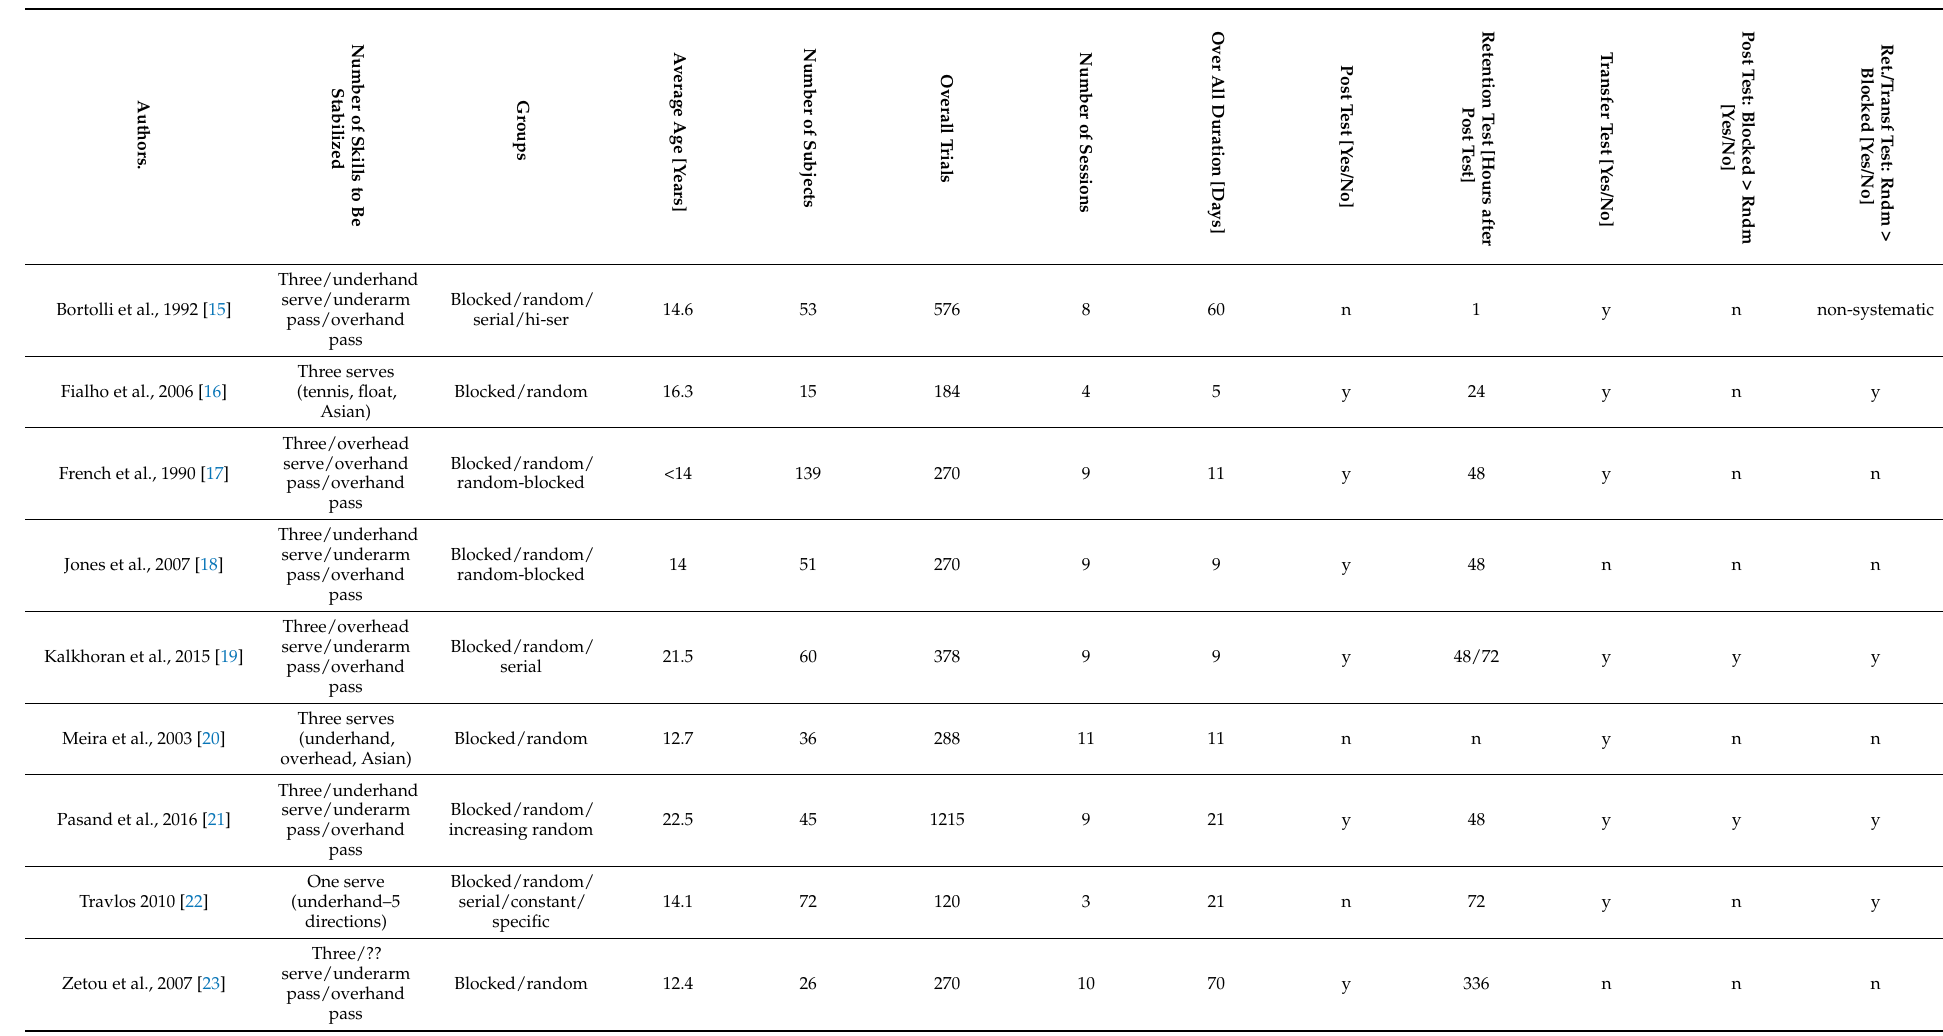
Table 1. Studies on stabilizing multiple volleyball skills in parallel within the contextual interference